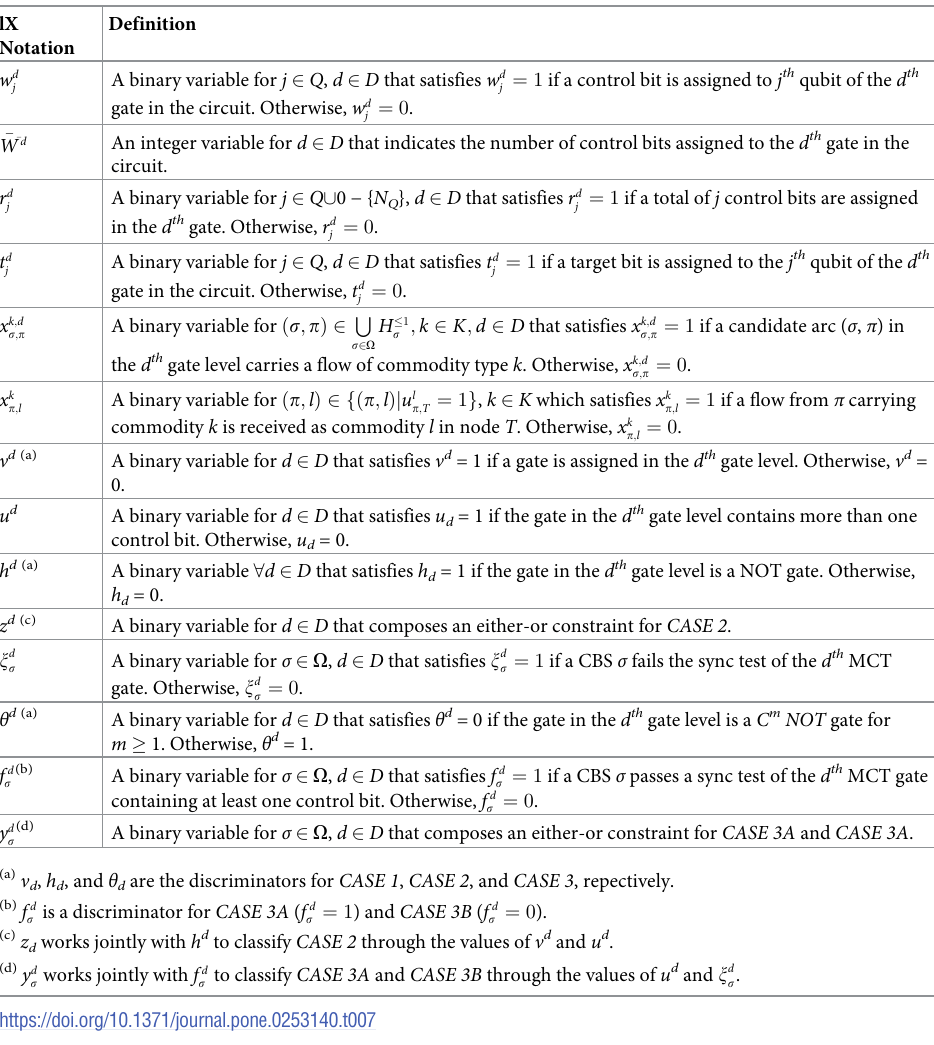
Table 7. Decision